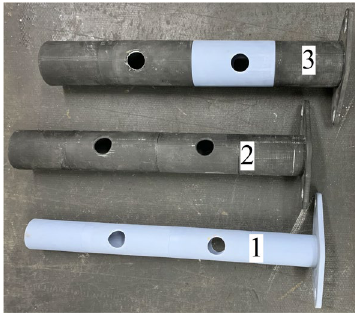
Figure 4. Photographs of the examined inlet pipes with different inner diameters d : 1— d = 26 mm; 2— d = 32 mm (basic configuration); 3— d = 40 mm. 2— d = 32 mm (basic configuration); 3— d = 40